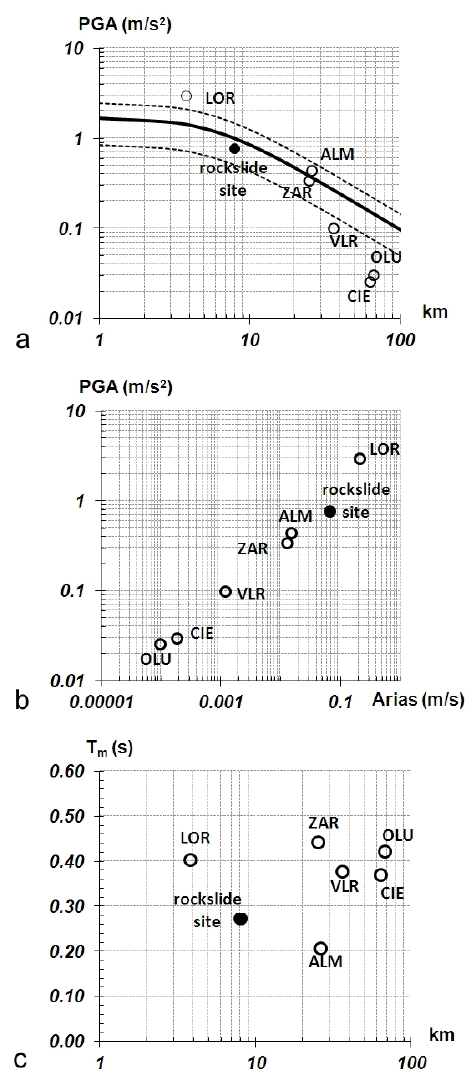
Fig. 6. (a) PGA vs. epicentral distance compared with the Italian Sa- betta and Pugliese (1987) attenuation law (black and dashed lines); (b) PGA vs. Arias intensity; (c) Tm vs. epicentral distance for the records of the 11 May 2011 mainshock of the Lorca seismic se- quence, recorded at the various accelerometric stations (empty sym- bols) and for the seismic input referred to the rockslide site, 8km from the main shock epicenter (full